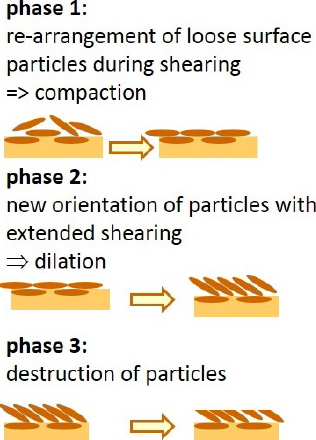
Figure 10. Conceptual sketch of particle arrangement explaining the observed time dependence of vertical displacement during shear.